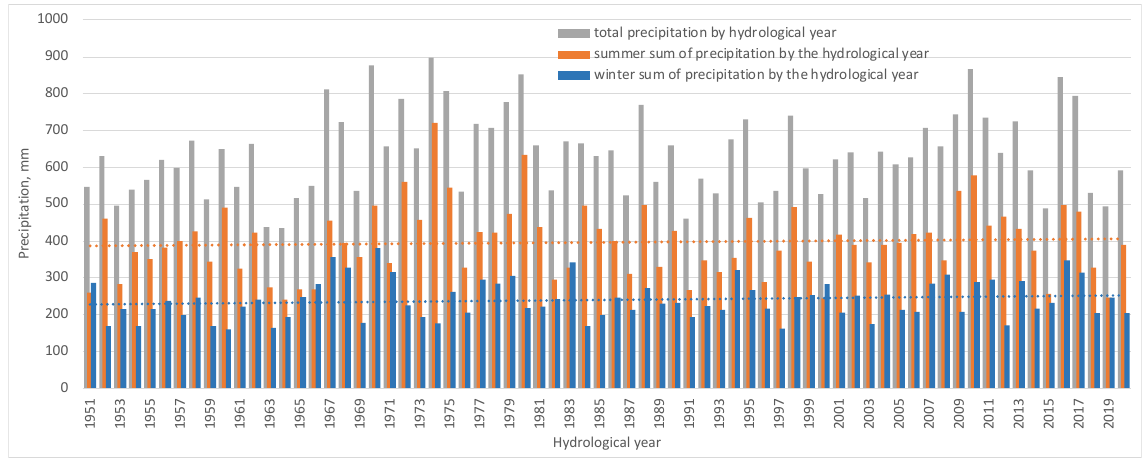
Figure 4. Precipitation and mean air temperature in the Narewka catchment area in the period 1951–2020. Table 1. A summary of the Mann–Kendall test statistics for the selected climatic and hydrological factors at the 95% confi- dence level. S, Z = statistics of the Mann–Kendall test, p = significance level, h.y. = hydrological year. The number of annual values in the calculation is